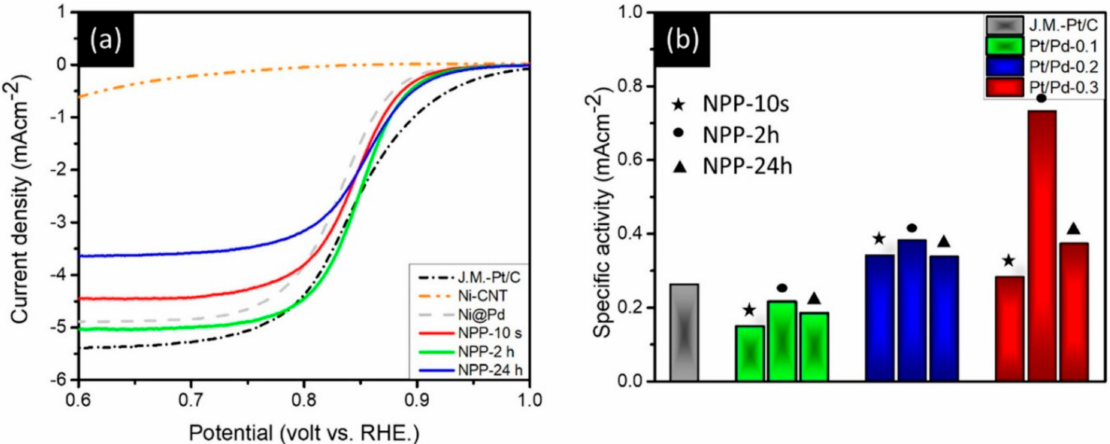
Figure 5. ( a ) The linear sweep voltammetry curves and ( b ) corresponding specific activities